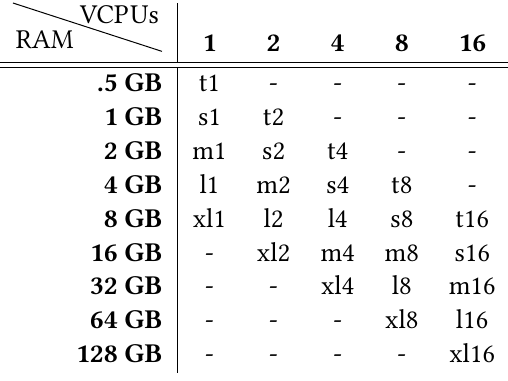
Table 1: OpenStack flavours